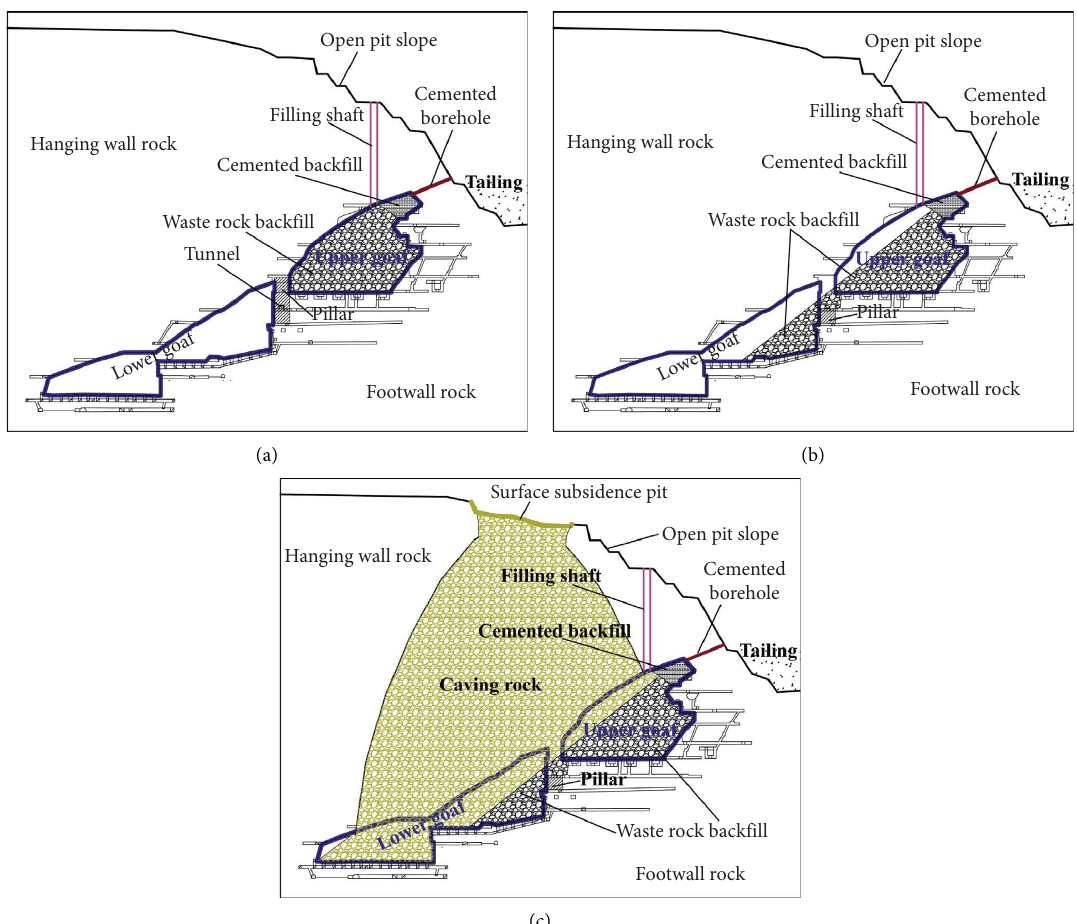
Figure 3: Comprehensive handling measure. (a) Filling the upper goaf. (b) Connecting the upper goaf with the lower goaf. (c) Filling the lower goaf.